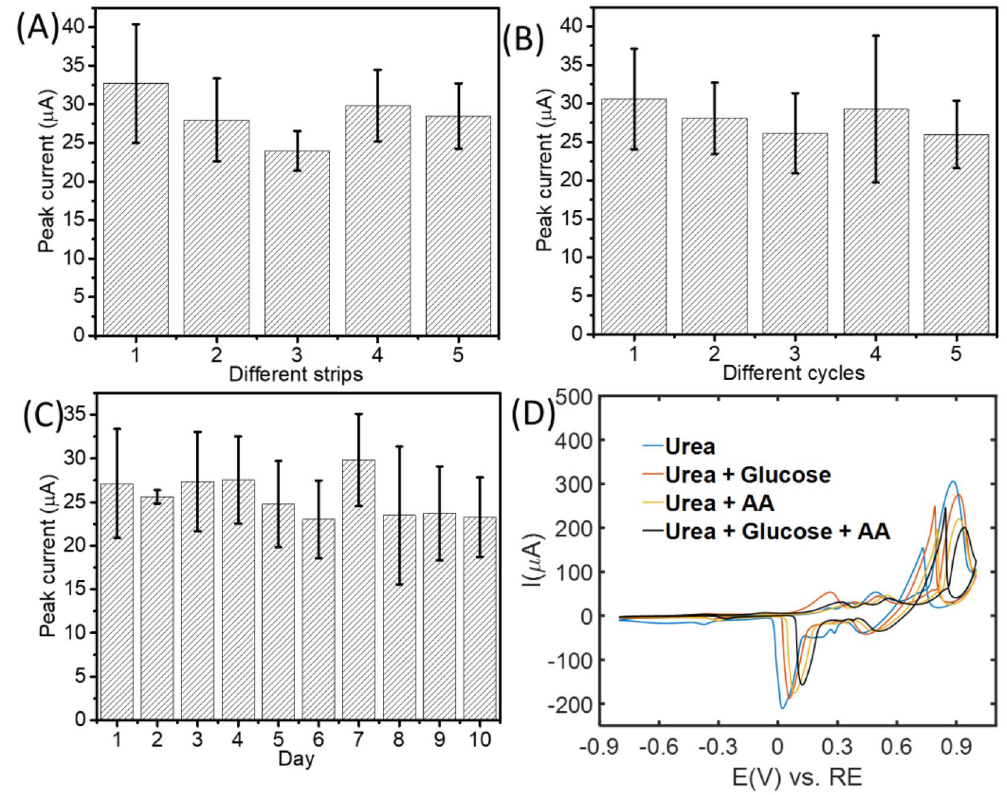
Figure 6. CV response of AgNP-coated glucose test strips in the presence of urea. ( A ) with different strips, ( B ) different cycles with the same strip, ( C ) with strips stored for different times, and ( D ) with interference of other substances glucose and AA. Electrolyte: 0.1 M NaOH; Scan rate: 50 mV/s.